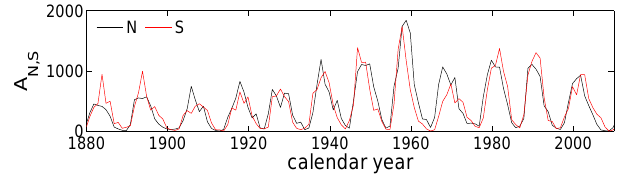
Figure 1. Monthly hemispheric sunspot areas (moving averages us- ing a window size of 12